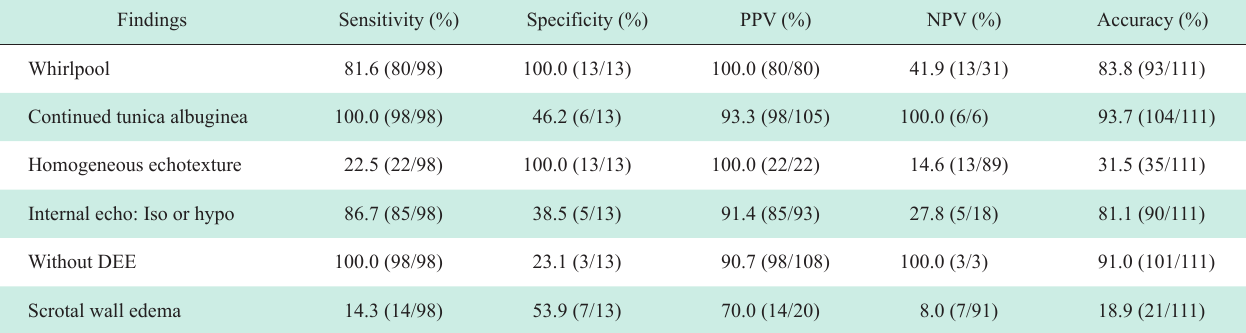
Table 3 Effectiveness of ultrasound findings for predicting testicular torsion in 111 patients with absent blood flow in the testis detected by color Doppler ultrasound